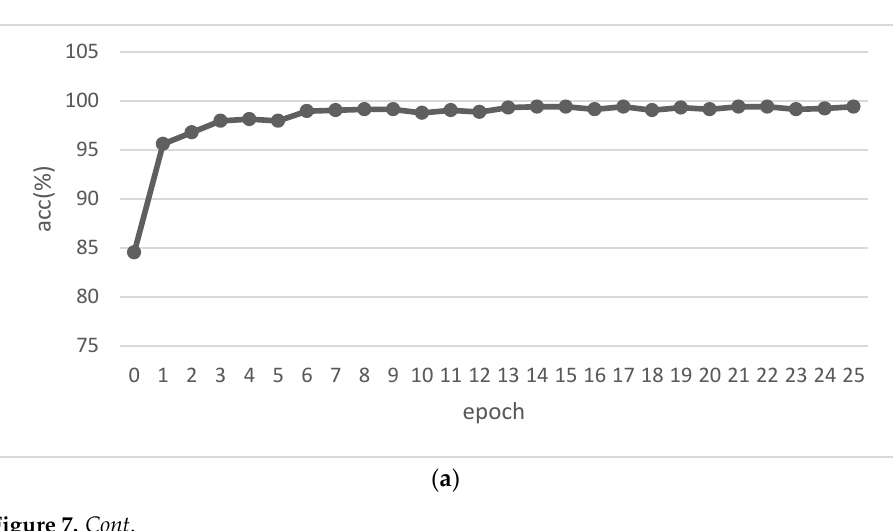
Figure 8. Confusion matrix. Table 5. Experimental results of our model.